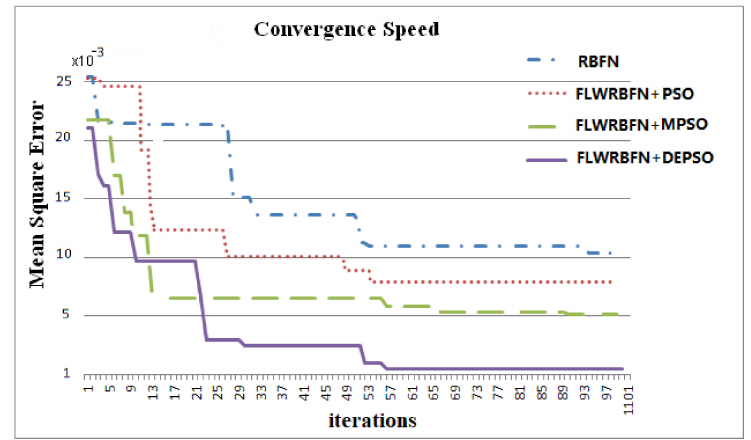
Figure 4. Convergence speed of the different methods under load